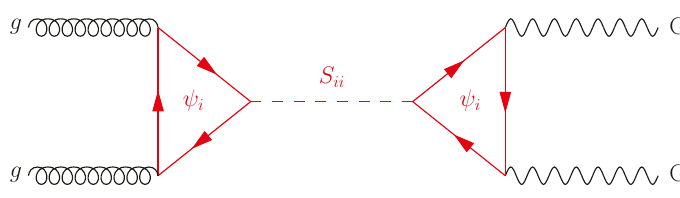
Figure 19 . Production via gluon fusion and decay of the scalar resonance S in the asymptotically safe SM extension (3.7). Here, i denotes the BSM (cid:13)avor index and GG stands for any combination of SM gauge bosons